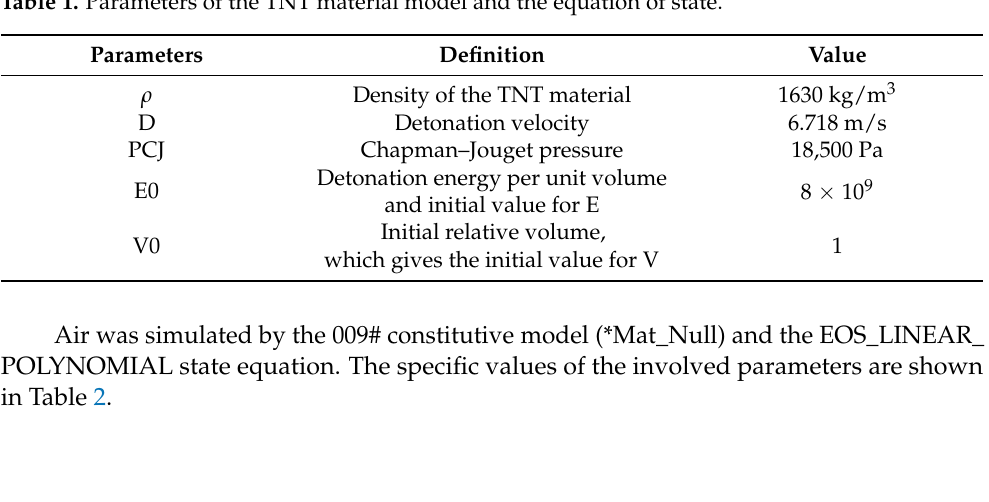
Table 1. Parameters of the TNT material model and the equation of